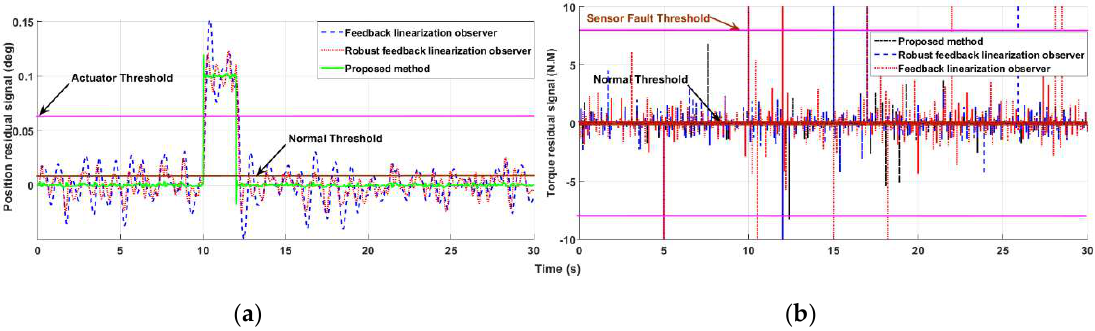
Figure 15. ( a ) Position residual signals and ( b ) torque residual signals for actuator fault identification based on the fuzzy ARX-Laguerre feedback linearization method, fuzzy ARX-Laguerre robust feedback linearization method, and fuzzy ARX-Laguerre T–S fuzzy robust feedback linearization method for the surgical robot for the sinus.